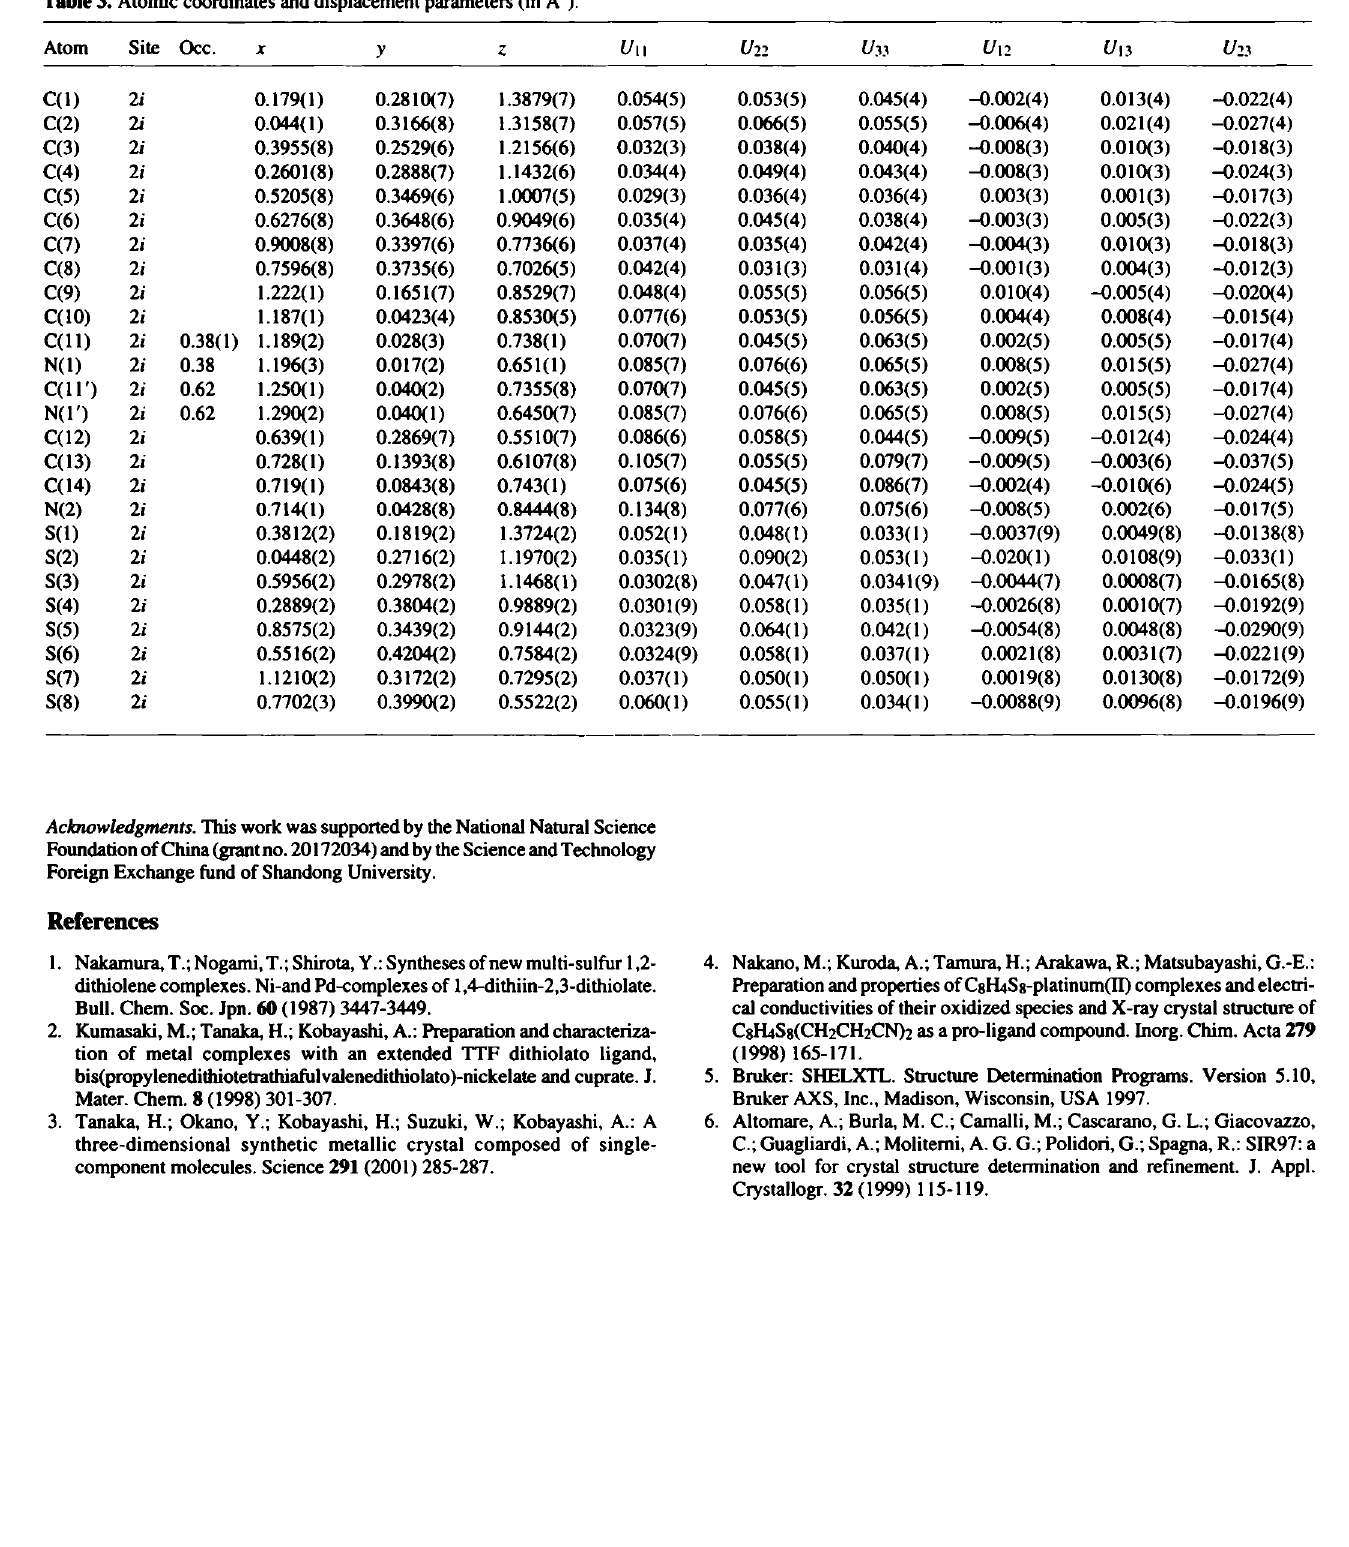
Table 3. Atomic coordinates and displacement parameters (in A 2